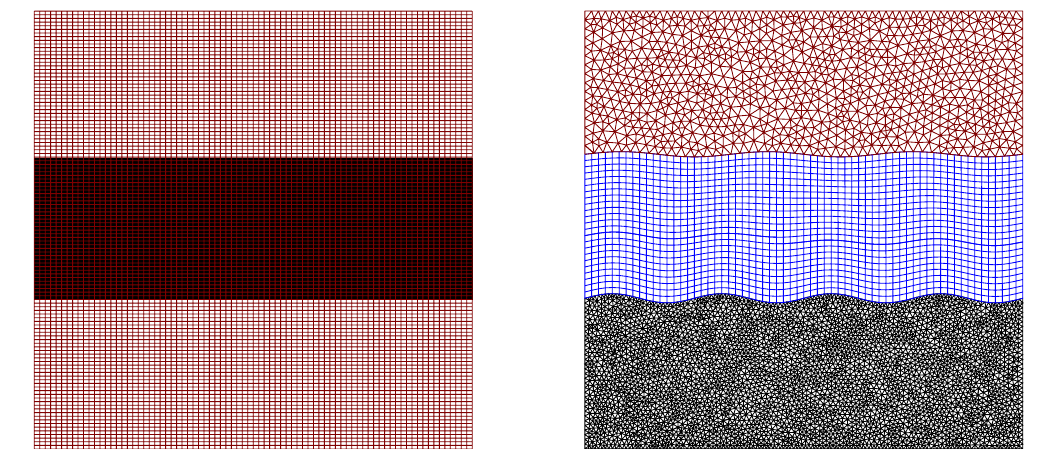
Table 2: DNDDM and MFEM meshes DNDDM